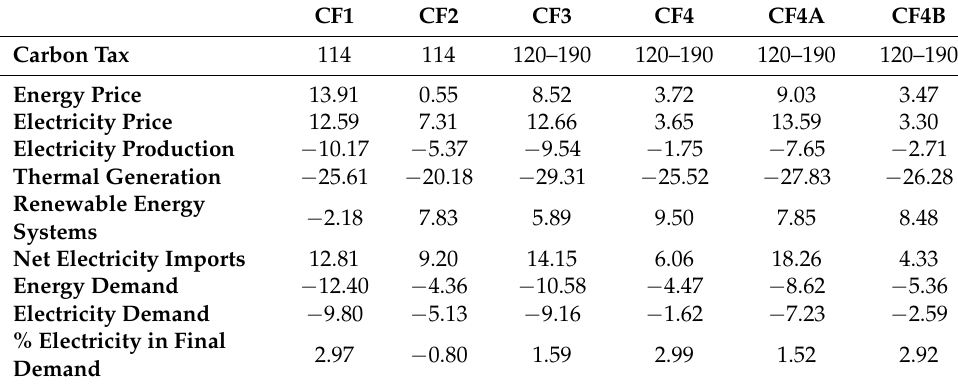
Table 3. Long run [2030] effects: energy markets.